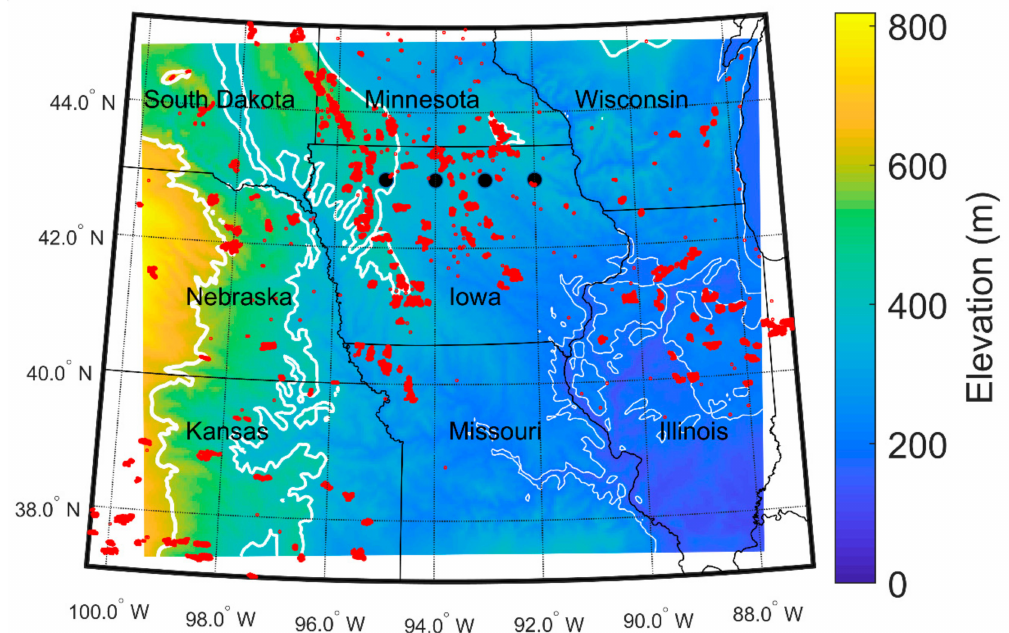
Figure 2. Map of the terrain elevation within the inner Weather Research and Forecasting (WRF) domain that is described using 4 × 4 km grid cells. The black lines show the state boundaries, and the white lines show terrain contours at 200 m (thinnest), 400 m and 600 m (thickest) used to denote the topography. The locations of individual WT are shown in red. These are from https: // eerscmap.usgs.gov / uswtdb / updated 14 May 2020 [37]. The location of the four sites on the transect at 43 ◦ N latitude across the north of Iowa are shown by the black